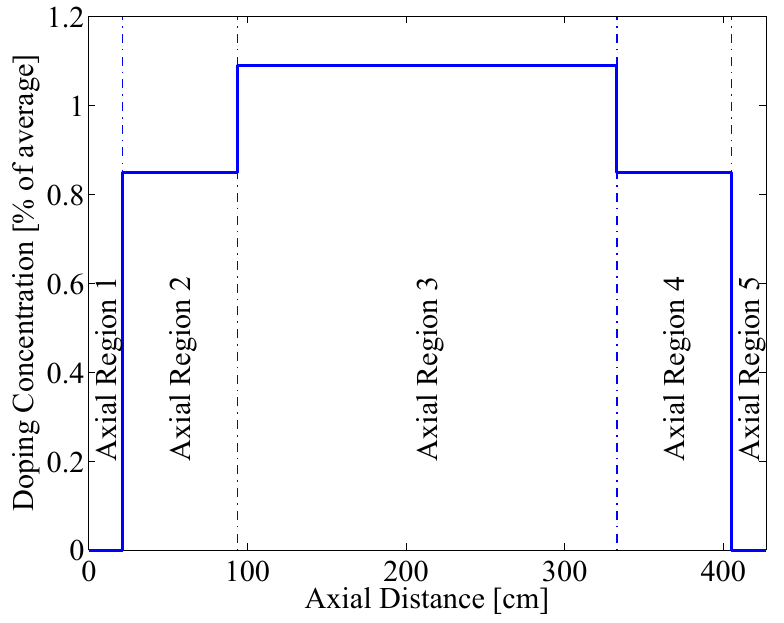
Figure 3. Axial distribution of burnable absorber in fuel. The uranium dioxide fuel was doped with boron and the inert matrix fuel with erbium oxide, both of which absorb neutrons and reduce the power output of the pin. Over time, both the born and the erbium burn